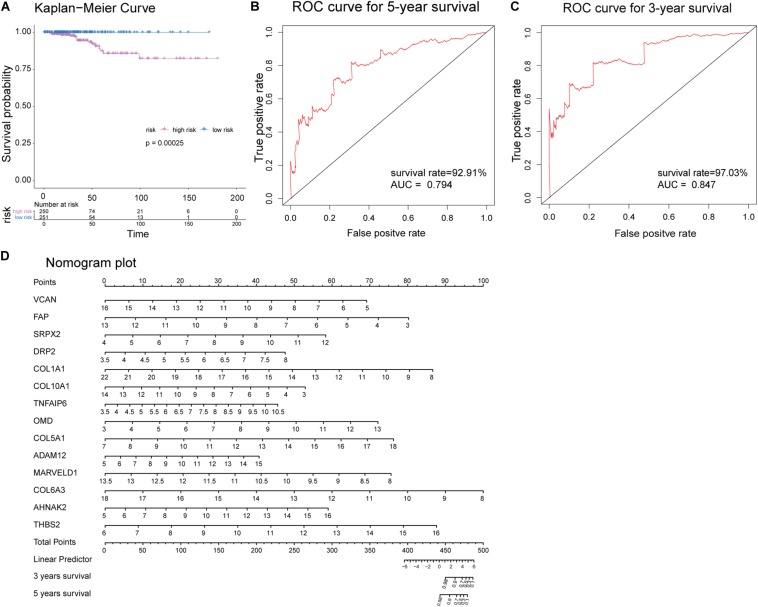
Evaluation of the optimized Cox proportional hazards model effectiveness. (A) Kaplan-Meier survival curves of high- and low-risk groups based on the median riskscores. (B,C) Time-dependent receiver operating characteristic (ROC) was used to evaluate the performance of Cox regression prognostic models for 3- and 5-year overall survival. (D) Nomogram plot was constructed with the 14 hub genes for overall survival. The effects of each hub genes can be converted into the point’s axis at the top of the nomogram. After adding the points of each hub genes and corresponding to the total point’s axis at the bottom of the nomogram, a patient’s probability of survival (3- and 5-year) can be predicted at the bottom of the nomogram.